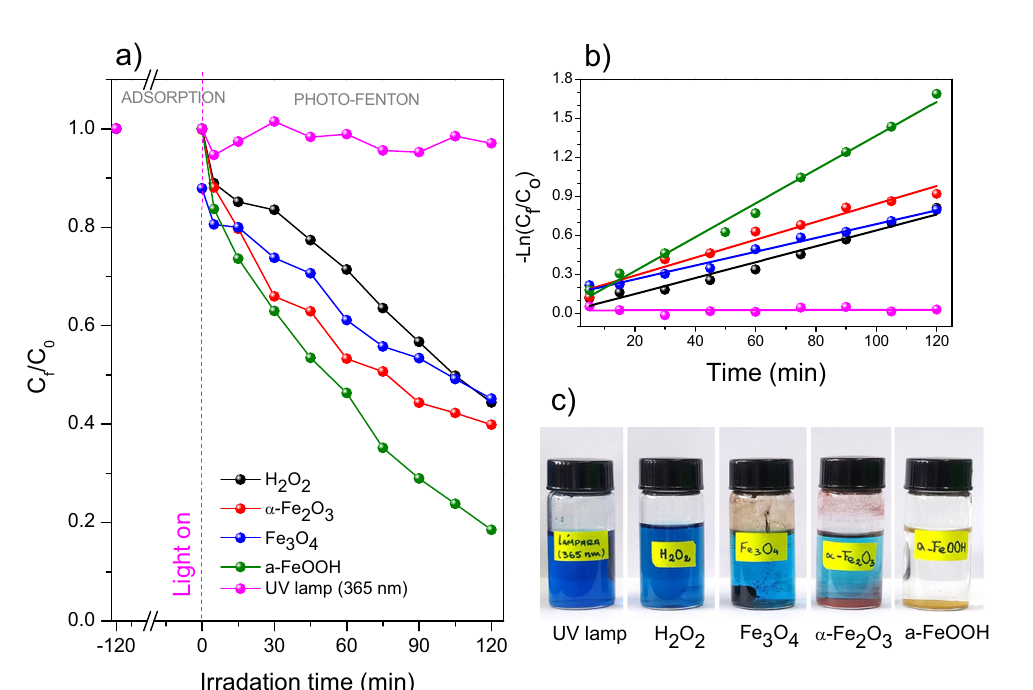
Figure 6: ( a ) MB photo - Fenton - like discoloration on iron oxide catalysts with 120 min of adsorption for a system containing 20 mg of catalyst, 15 mL of 25 mg L − 1 of MB and 1 mL of H 2 O 2 30 wt%, ( b ) linear regression of the MB photo - Fenton - like discoloration on di ff erent iron oxides from ( a ) , and ( c ) photographs of MB discoloration at the end of the